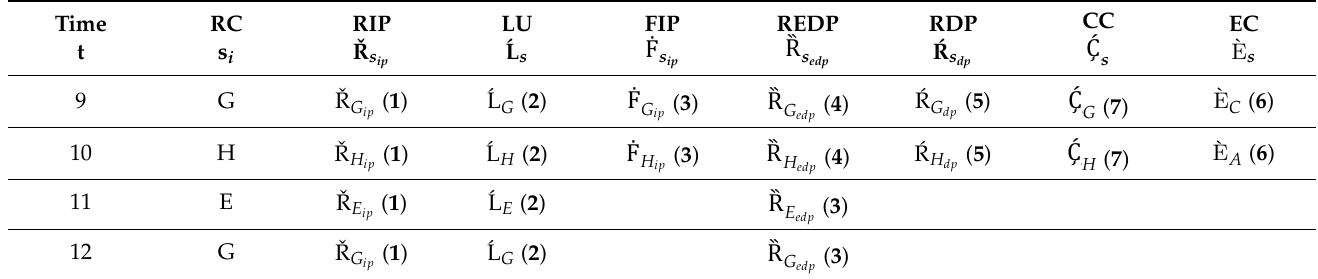
Table 5. Caching process at t = 9 to t = 12.